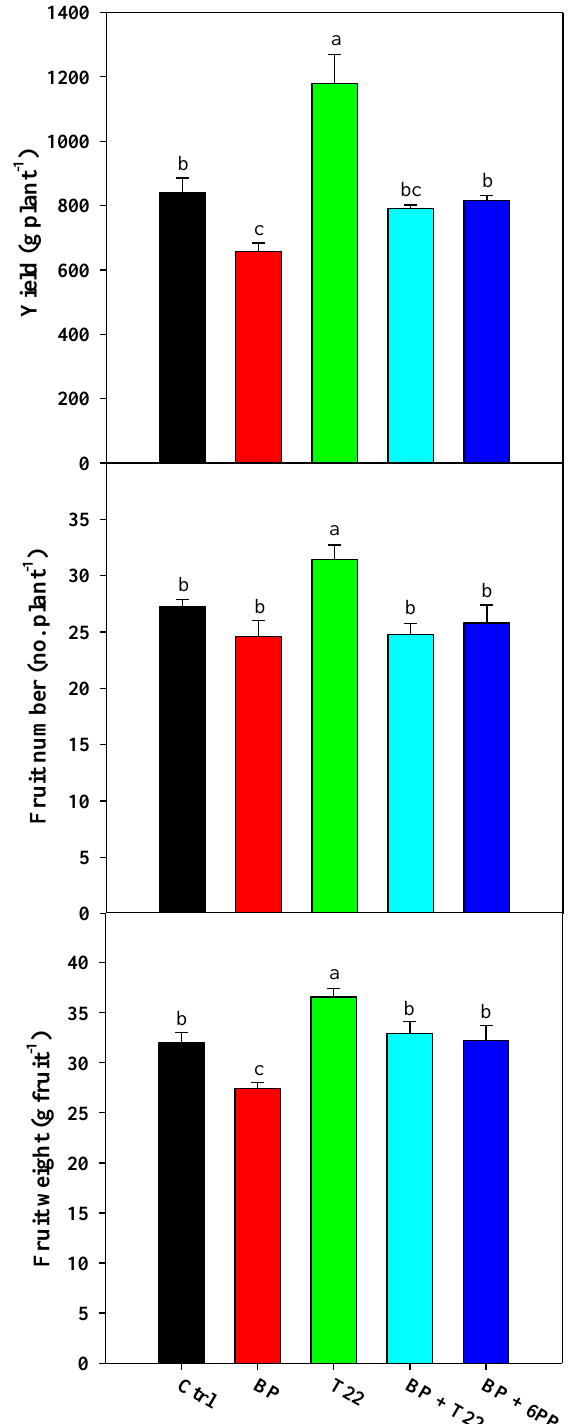
Figure 1. Effects of Trichoderma harzianum strain T22 (T22) or biopolymer (BP) applications alone, or in combinations of BP + T22 or BP + 6-pentyl-α-pyrone [6PP] (BP + 6PP), on fresh yield ( A ), fruit number per plant ( B ) and mean fruit weight ( C ) of greenhouse plum tomato. The control was not treated with biostimulants (Ctrl). Values are the means of three replicates ± SE. Different letters indicate significant differences according to Duncan’s test ( p = 0.05).